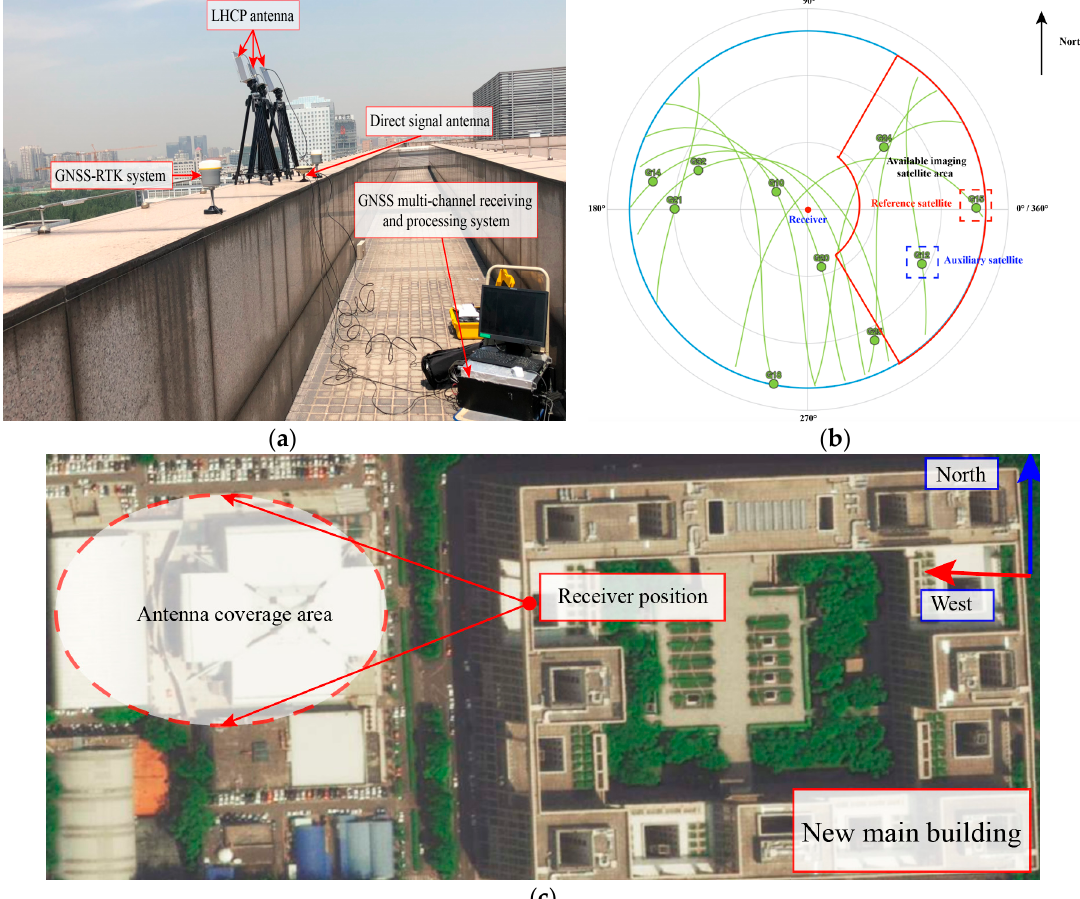
Figure 14. Experiment specific configuration: ( a ) experimental equipment hardware, ( b ) sky map at the time of collection, ( c ) optical image of experimental area. Table 4. Parameters used in the experiment.